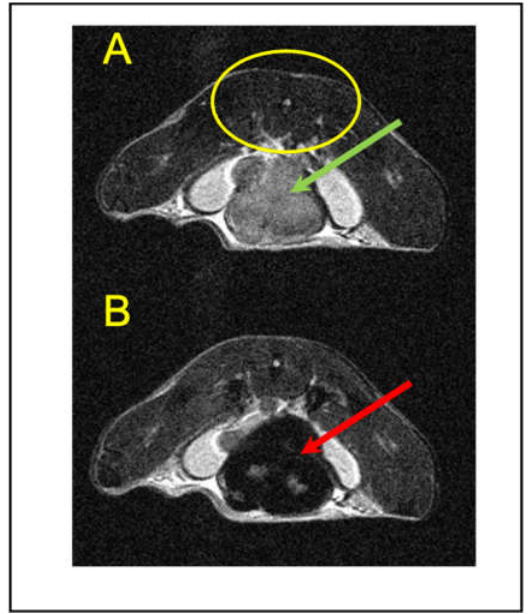
Figure 1. MR images of mice bearing EF43.fgf4 tumors (indicated by arrows) in the mouse mammary fat pad. ( A ) Control RARE image (T R = 5 s, T E = 14 ms) prior to injection of the SPIONs; note that the tumor (green arrow) is hyperintense with respect to the psoas muscle (yellow ellipse) as reflected by the tumor/muscle contrast value of C pre = 1.79 ± 0.13. ( B ) A RARE image taken ~24 h after SPIONs injection into the tail vein showing a marked decrease in tumor (red arrow) MR signal intensity resulting in a tumor/muscle contrast of C post = −0.39 ± 0.13 ( n = 5 slices). These images are representative of data from 25 slices from five separate mice.